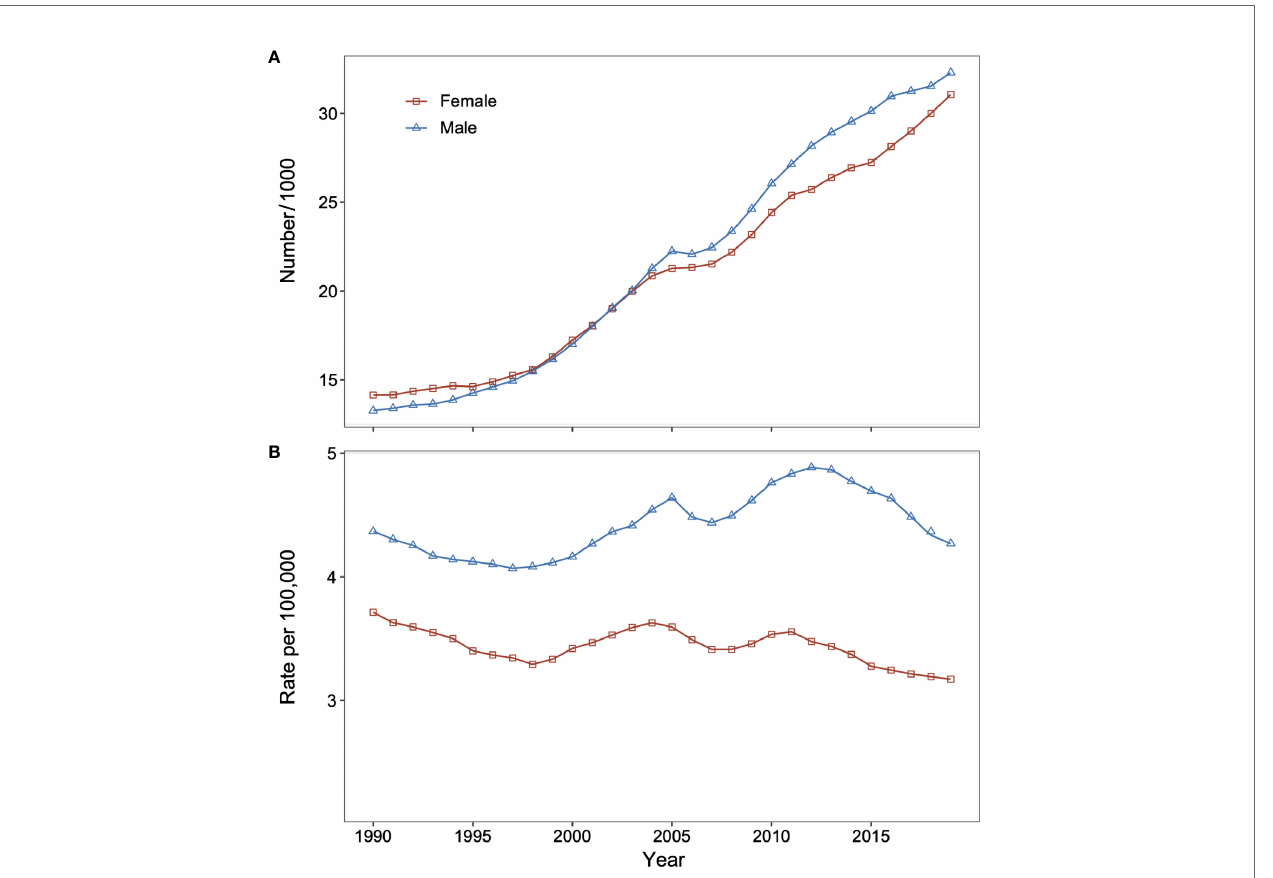
FIGURE 1 | Changes in type 2 diabetic kidney disease (DKD) mortality and number of deaths for males and females in China from 1990 to 2019. (A) Number of DKD deaths for males and females. (B) Age-standardized death rate of DKD for males and females. DKD, type 2 diabetic kidney